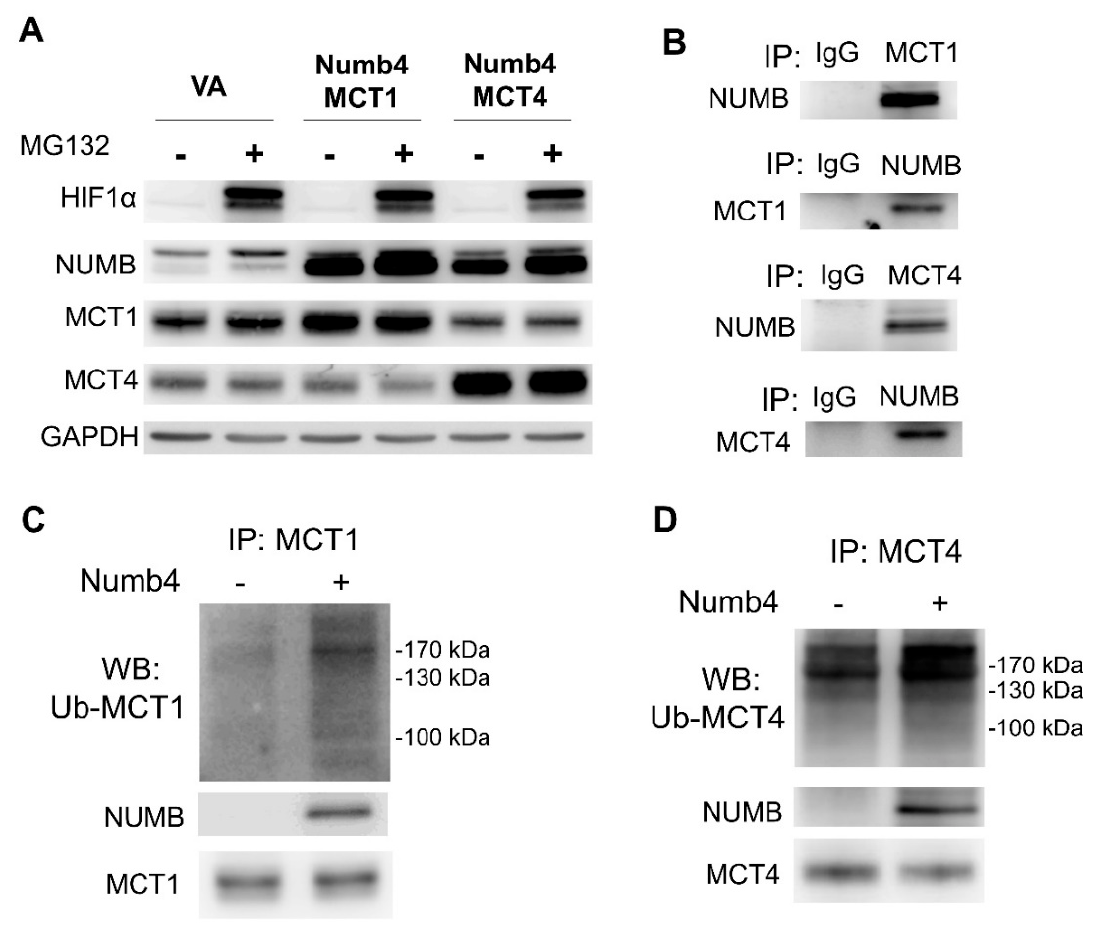
Figure 6. Numb4 binds MCT1 and MCT4 and facilitates their polyubiquitination. ( A ) Western blot analysis of 293T cells transfected with Numb4, MCT1, and MCT4 constructs and treated with MG132. HIF1 α expression serves as a control to validate the efficacy of MG132. Treatment with 20 µ M MG132 for 8 h increased the abundance of endogenous and exogenous NUMB, but it did not consistently affect exogenous or endogenous MCT1 or MCT4. Exogenous MCT4 expression decreased the abundance of endogenous MCT1. ( B ) Immunoprecipitation. Immunoprecipitates generated by anti-NUMB antibody contained MCT1 and MCT4 in 293T cells. Immunoprecipitates generated by anti-MCT1 or anti-MCT4 antibody also contained NUMB. ( C ) Enhanced polyubiquitination of MCT1 in the immunoprecipitates generated by anti-MCT1 following Numb4 expression in SAS cells. ( D ) Enhanced polyubiquitination of MCT4 in the immunoprecipitates generated by anti-MCT4 following Numb4 expression in 293T cells. VA, vector alone.